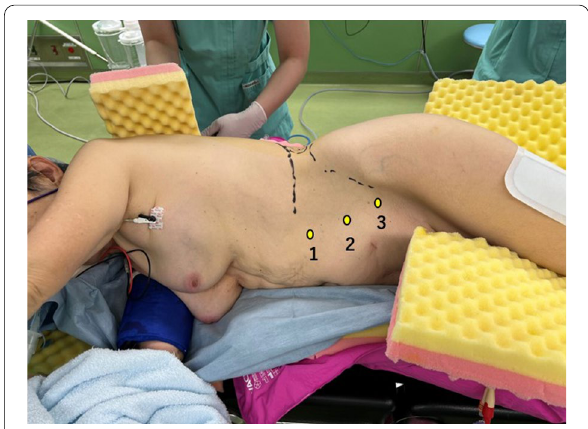
Fig. 2 Operative posture of the patient. Under endotracheal general anesthesia, the patient was placed in the right lateral position. The trocar sites were indicated as 1, 2 and